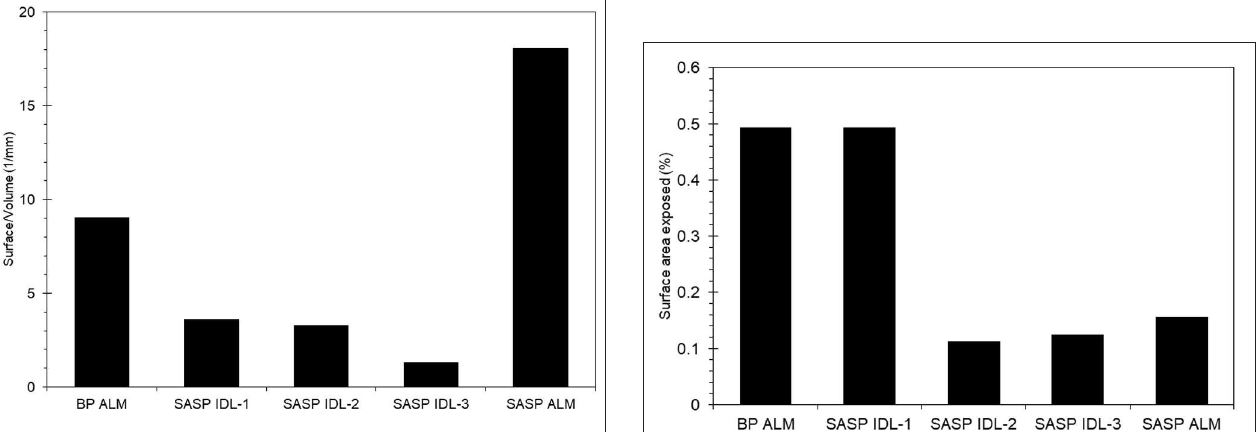
Frontiers in Earth Science |